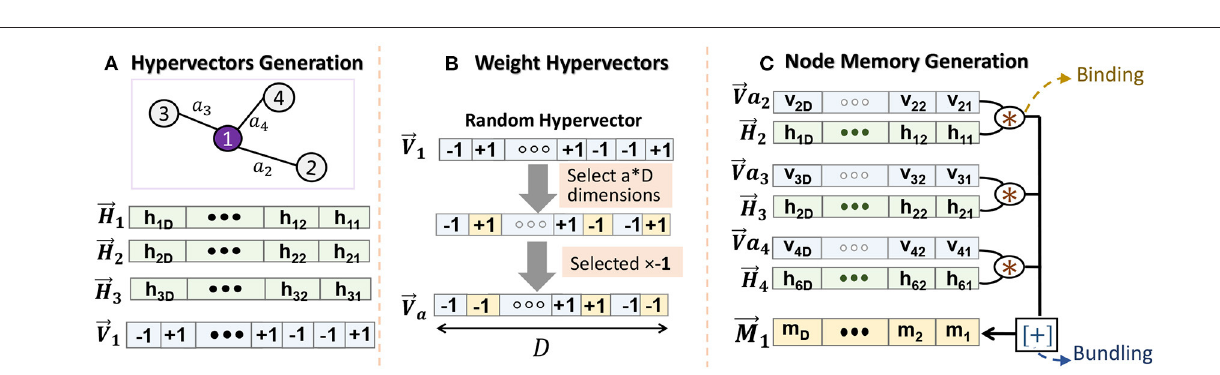
1. We define this evaluation of − a , where the final equality follows from the definition of